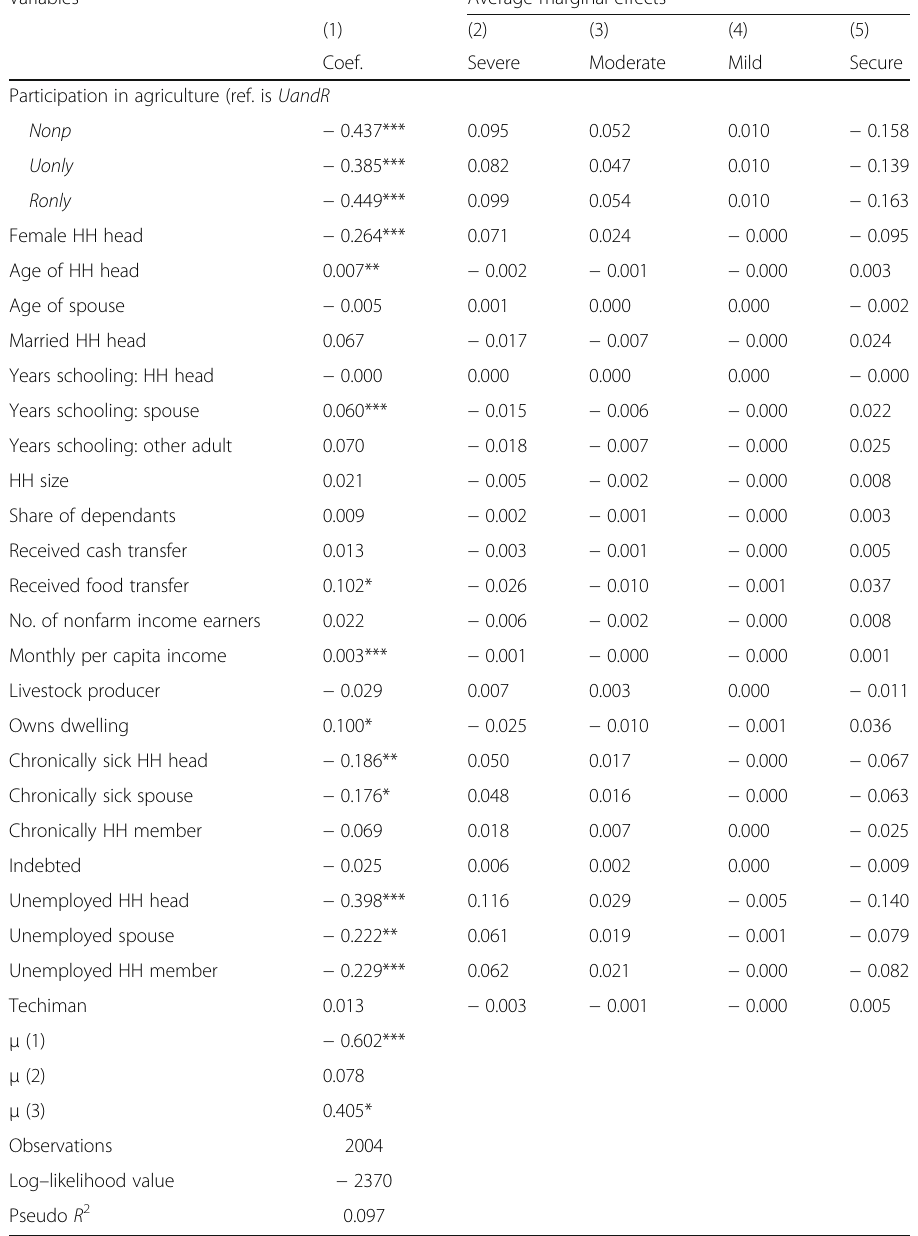
Table 4 Ordered probit estimates of participation in agriculture and food security (overall sample)